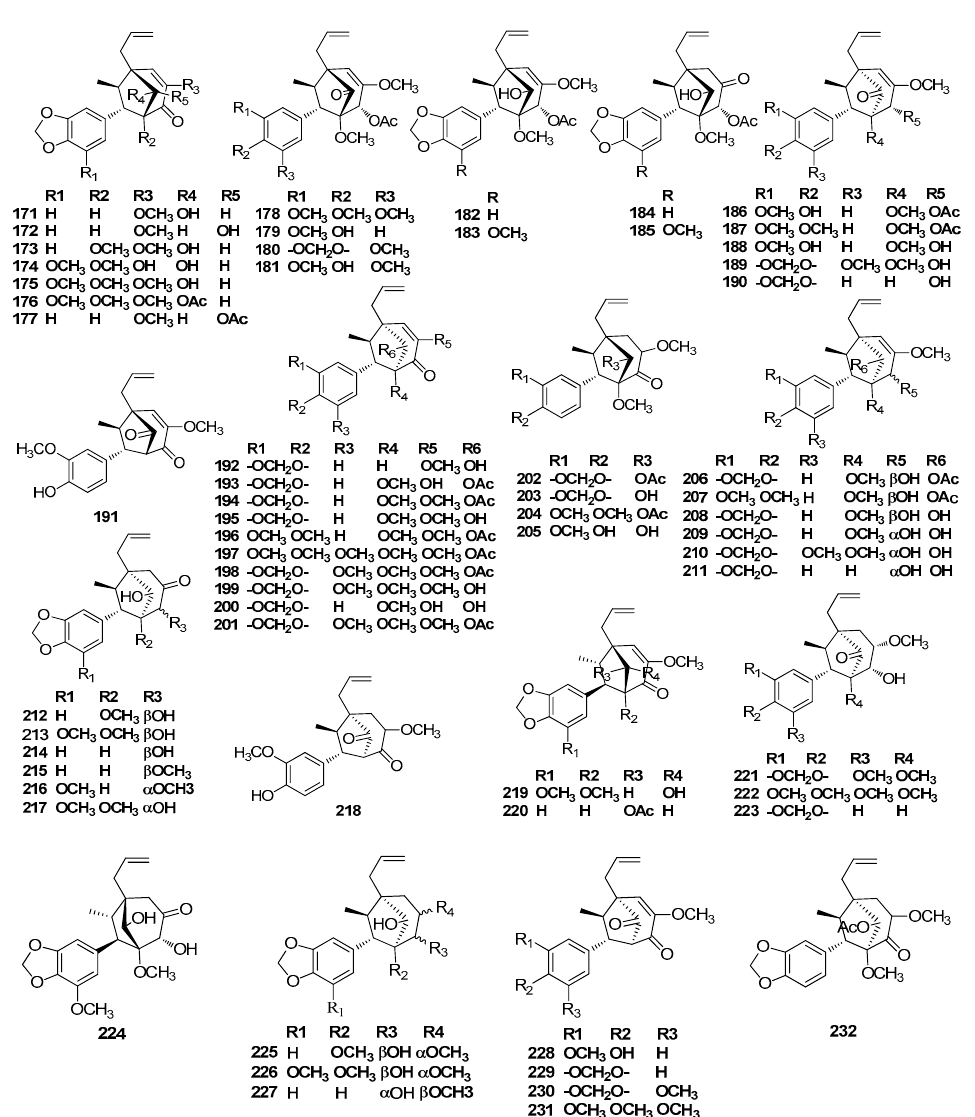
Figure 12. Chemical structures of 7.3’,8.1’-cycloneolignans.